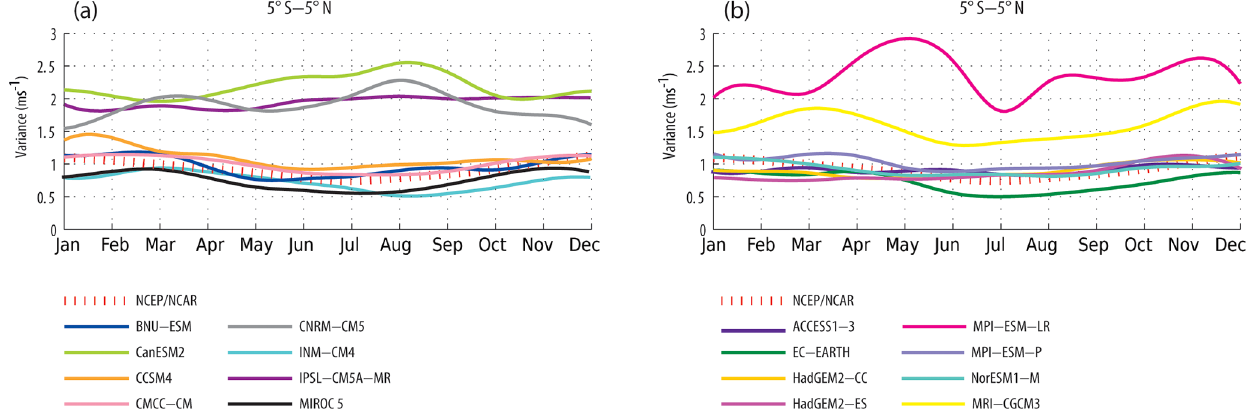
Figure 5. Seasonal variances (rms) of Rossby waves averaged zonally over the tropical Pacific (120 ◦ E–90 ◦ W) and meridionally over 5 ◦ S– 5 ◦ N for NCEP/NCAR Reanalysis and the CMIP5 models.